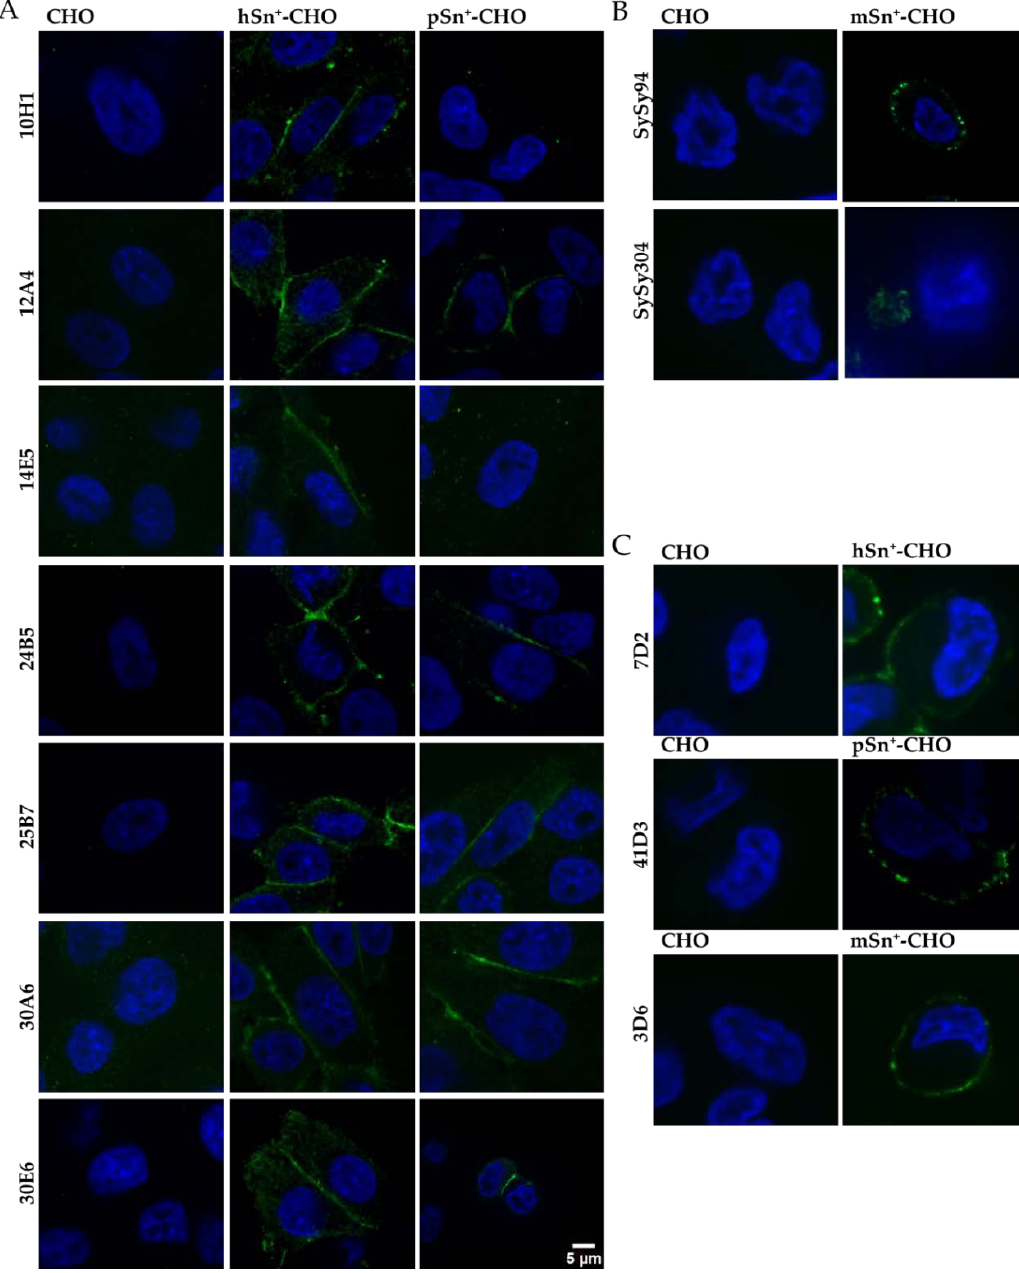
Figure 1. Microscopic analysis of surface staining of sialoadhesin (Sn) on CHO cells. Monoclonal antibodies (mAbs) were added to fixed Sn + CHO cells to analyze the recognition of surface Sn. Secondary Alexa Fluor 488-labeled antibodies were added to bind with the mAbs (green), nuclei were stained with 4',6-diamidino-2-phenylindole (DAPI) (blue). Wild-type CHO cells were used as control cells. ( A ) All anti-hSn mAbs were tested against hSn + -CHO and pSn + -CHO; ( B ) anti-mSn mAbs were used to stain mSn + -CHO; ( C ) reference mAbs 7D2, 3D6, and 41D3 were analyzed for recognition of hSn + -, pSn + -, and mSn + -CHO cells, respectively.